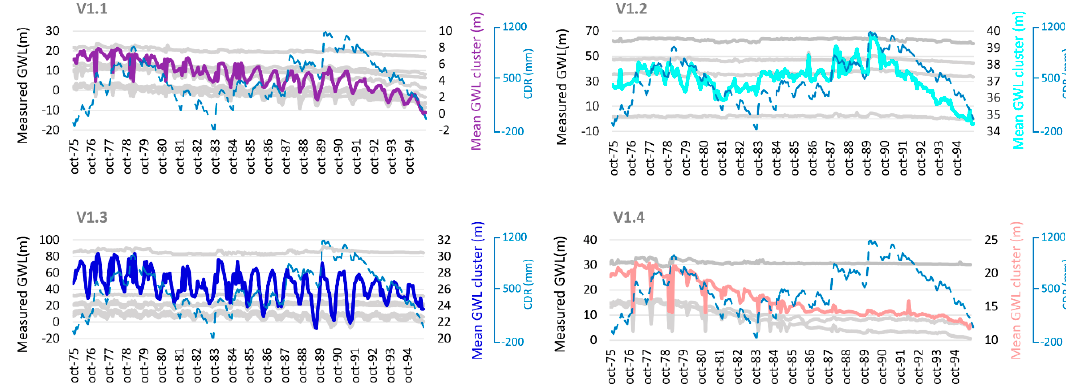
Figure 4. Groundwater levels ( GWL) series (grey lines), mean of the GWL cluster series (colored lines) from October 1975 to September 1995 by visual clustering and cumulative deviation from the mean monthly rainfall (CDR).